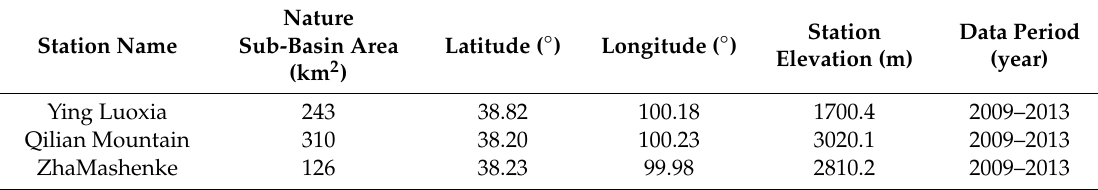
Table 1. Hydrological stations data statistics in Heihe River Basin